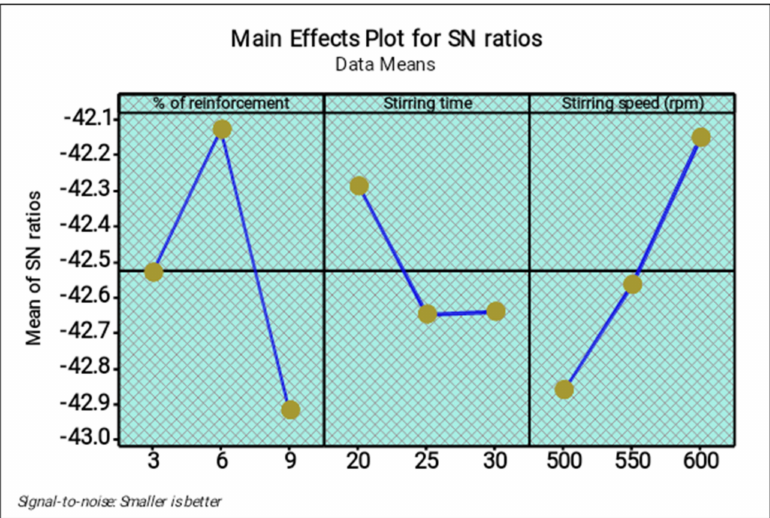
Figure 10. Main effect plot for means (wear).